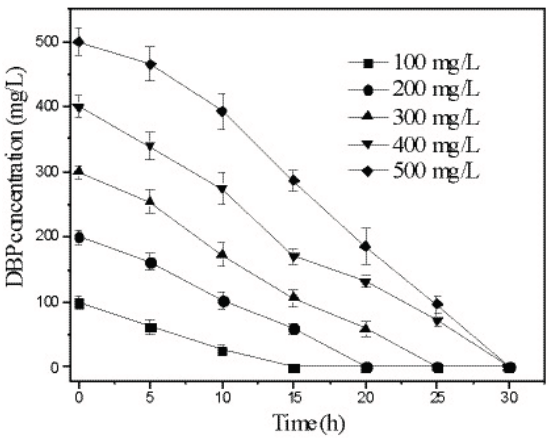
Figure 5. Degradation rate at different initial DBP concentrations. Error bars are the SEM of DBP concentration from triplicate experiments.